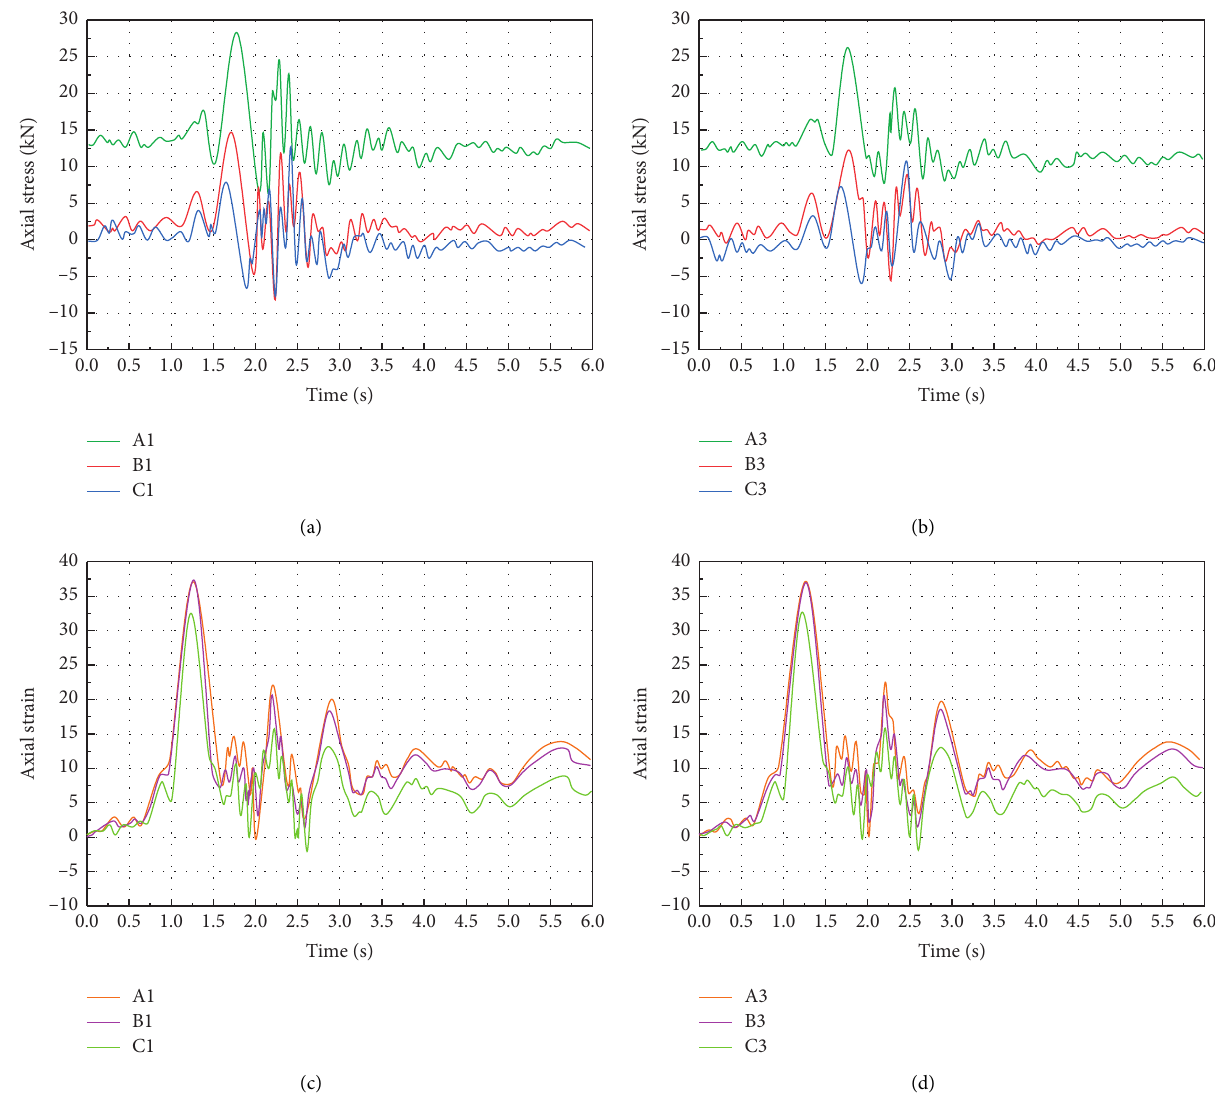
Figure 9: Axial stress-strain curve of partial bolt: (a) anchor axial stress time history curve of bolt No. 1; (b) anchor axial stress time history curve of bolt No. 3; (c) axial strain time history curve of bolt No. 1; (d) Axial strain time history curve of bolt No.